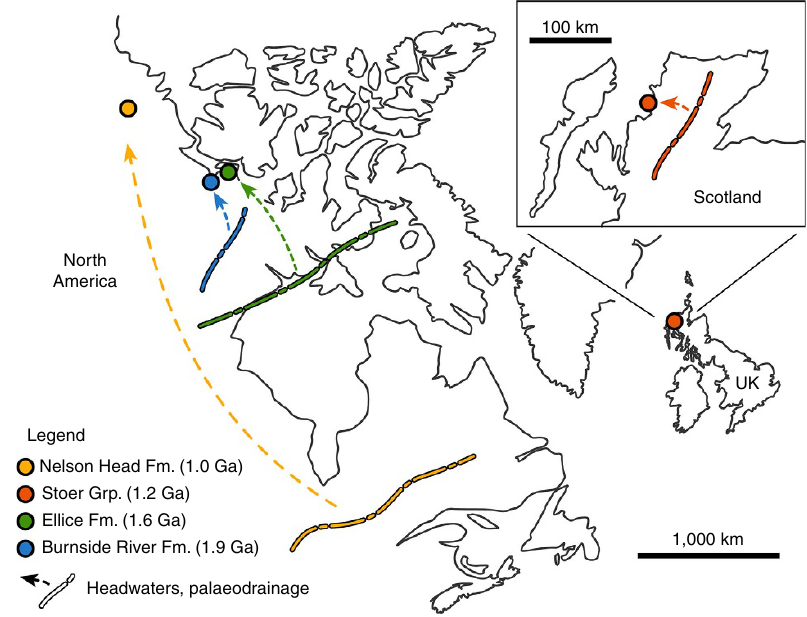
Figure 1 | Location and palaeogeography of the data set. Relative position of the considered rock units in an approximate reconstruction of the Neoproterozoic North Atlantic region 50 , with approximate position of headwaters and palaeodrainage vectors